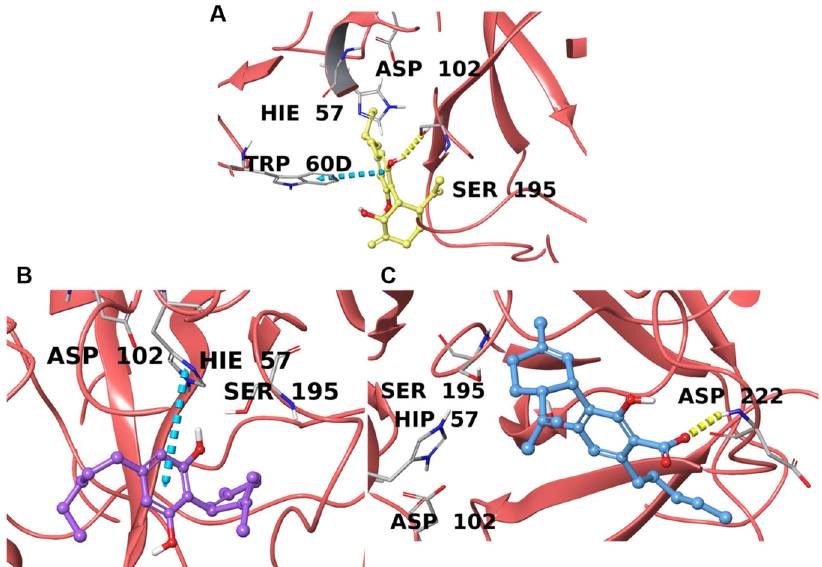
Figure 3. Binding poses of 1 ( A ), 2 ( B ), and 3 ( C ) in the catalytic domain of thrombin (PDBs 6ZUX, 6ZV8, and 1RD3, respectively) are represented with red ribbons. The hydrogen bonds are depicted as yellow dotted lines and π - π stacking interactions as cyan dotted lines. Interacting residues and catalytic triad amino acids are labeled.